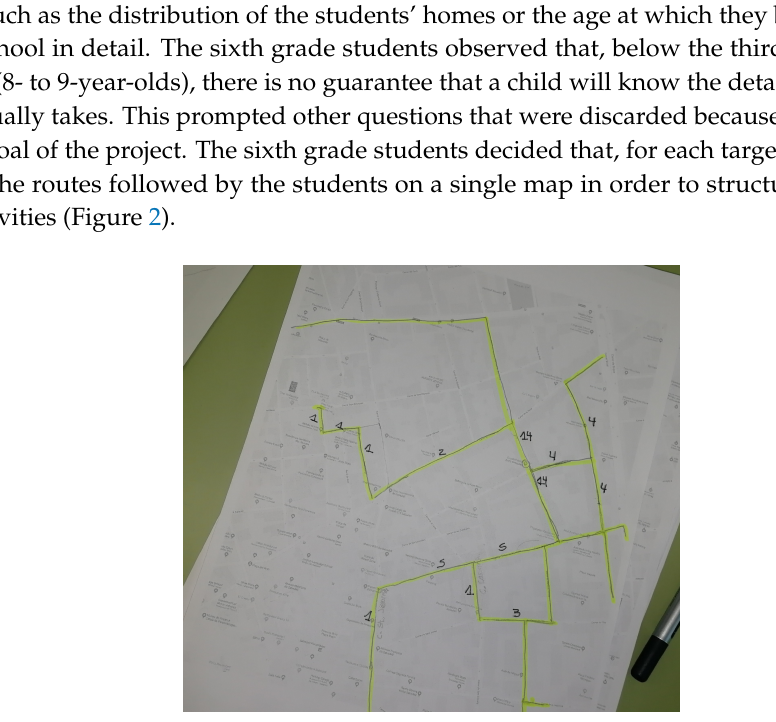
Figure 2. A map showing the routes taken by the students in a target class.